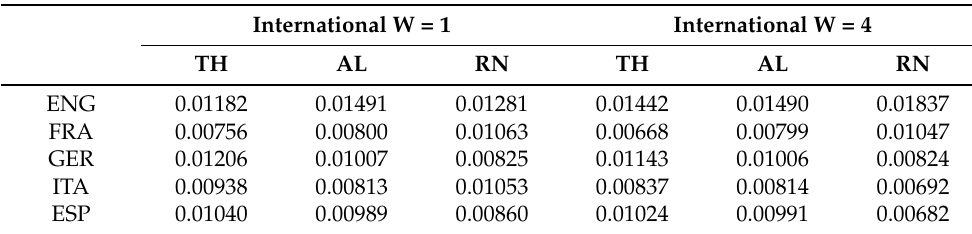
Table 9. Average weight values of the teams by